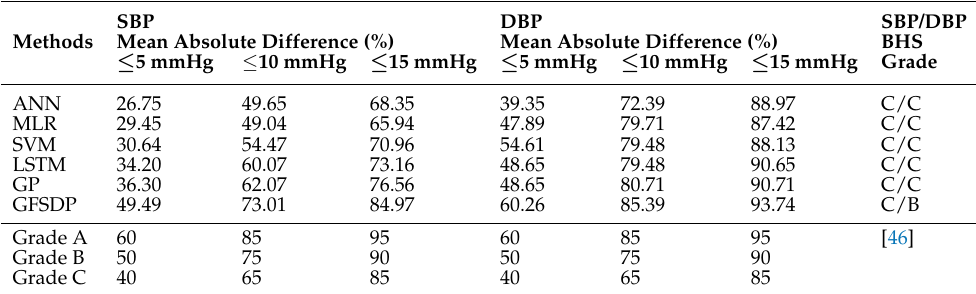
Table 8. We used the results of the ANN, MLR, SVM, LSTM, GP algorithms and the proposed GFSDP algorithm to grade the algorithm based on the BHS standard [46], where each result represents the average of 30 experimental